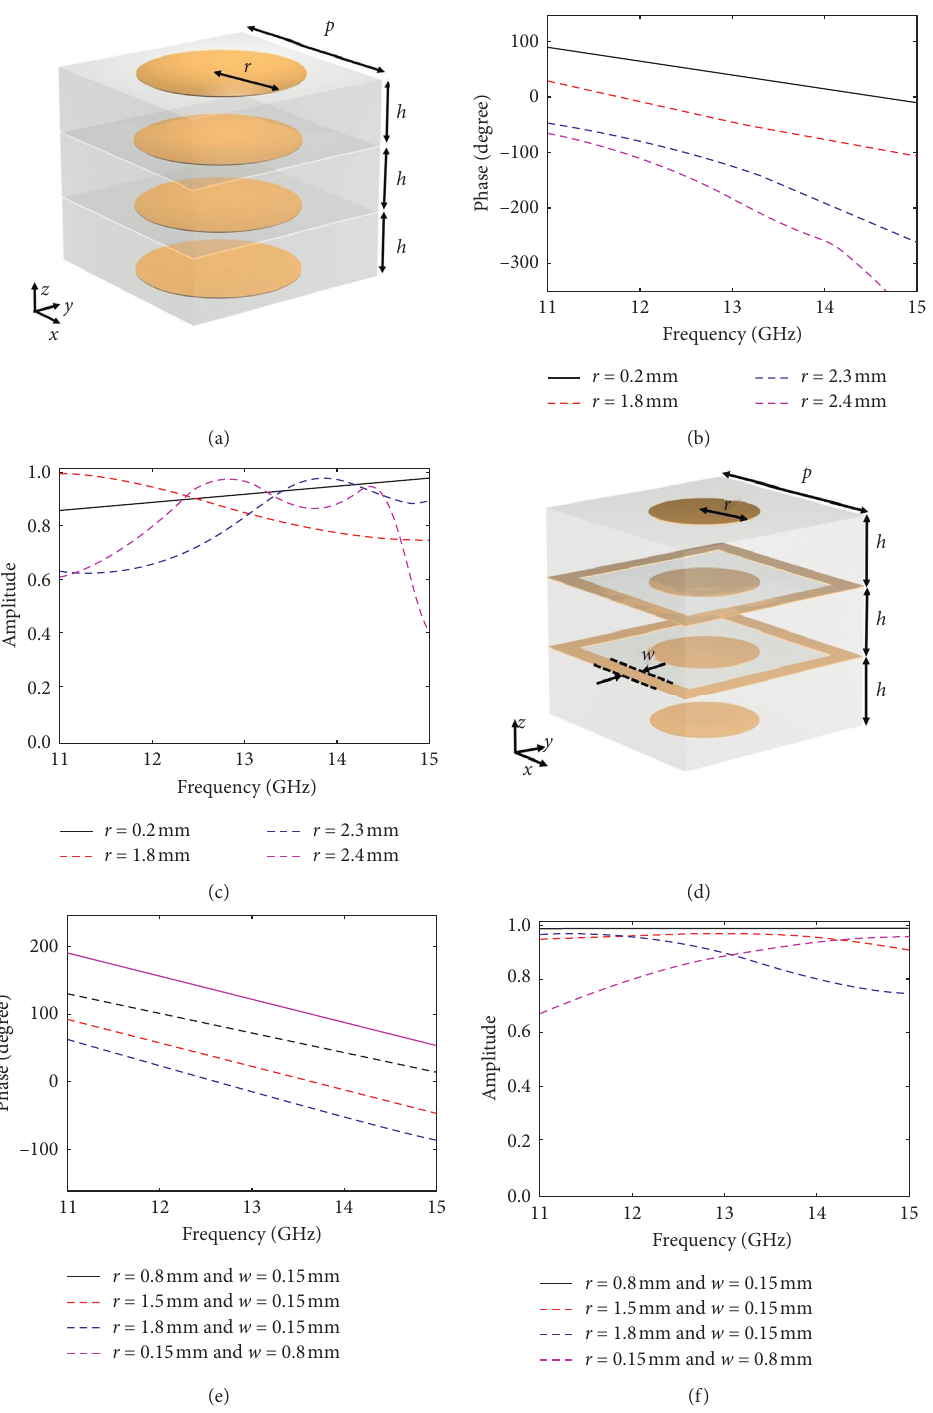
Figure 2: (a) Schematic of the proposed meta-atom composed of identical metallic patterns, and its (b) transmission phase and (c) transmission amplitude as functions of geometric parameters and frequencies. (d) Schematic of the proposed meta-atom composed of different metallic patterns, and its (e) transmission phase and (f) transmission amplitude as functions of geometric parameters and